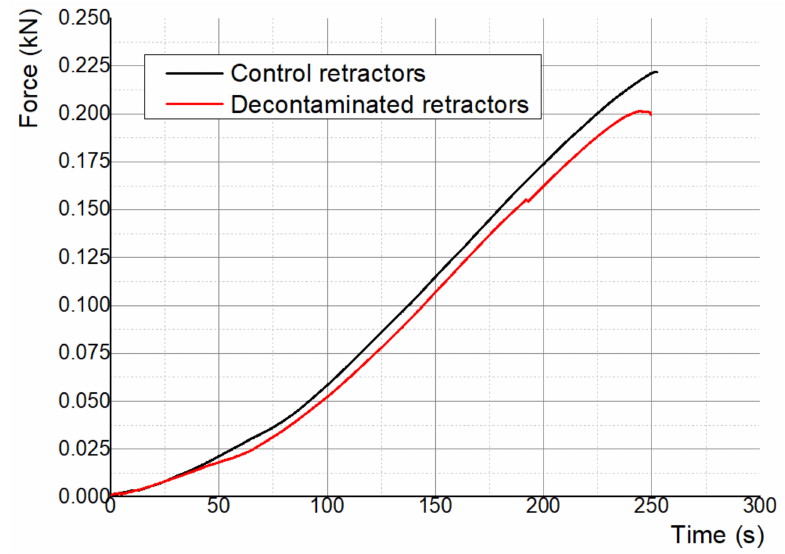
Figure 10. Mechanical test results for